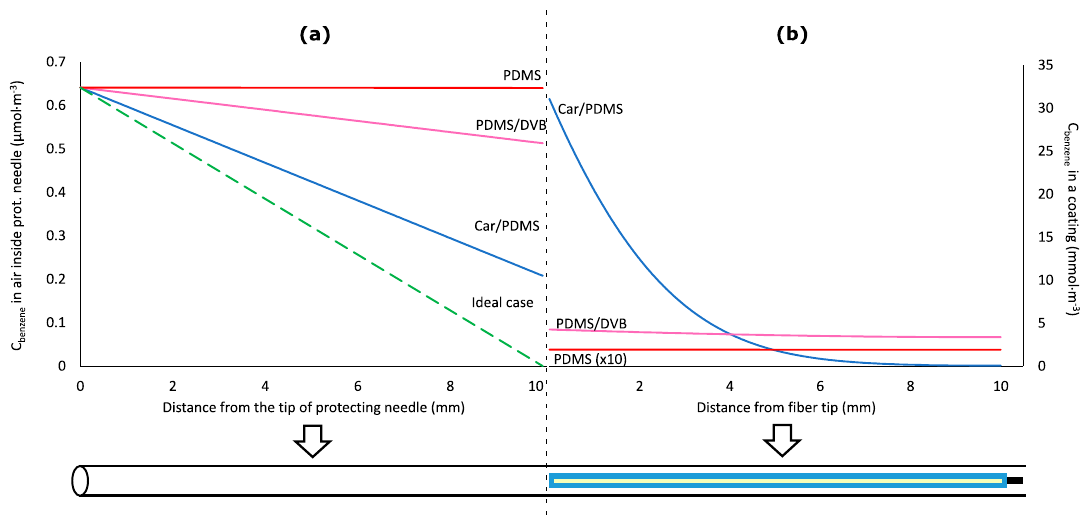
Figure 3. Concentrations of benzene in diffusion path air ( a ) and coating ( b ) of the retracted solid-phase microextraction (SPME) device after 100,000 s of time-weighted average (TWA) air sampling at Z = 10 mm.